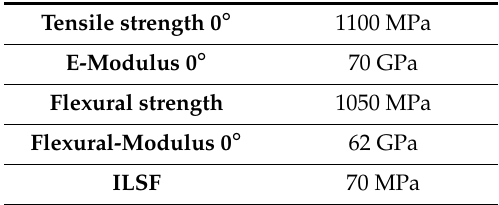
Table 2. HT – carbon fiber / 60 vol. % properties [23–25].